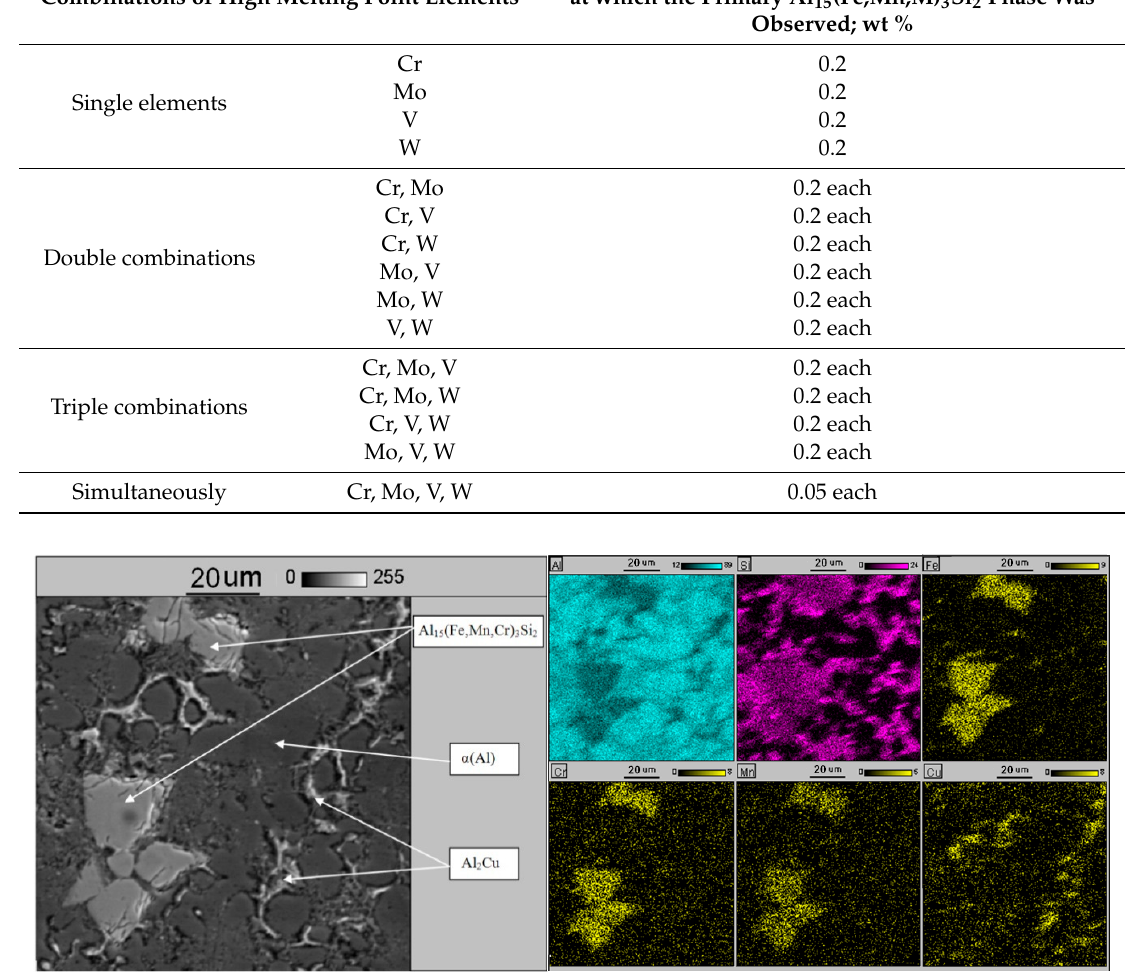
Figure 15. Microstructure of the HPDC Al-Si alloy containing approximately 0.25 wt % Cr, Mo, V, and W each with a marked example of the tested phase.